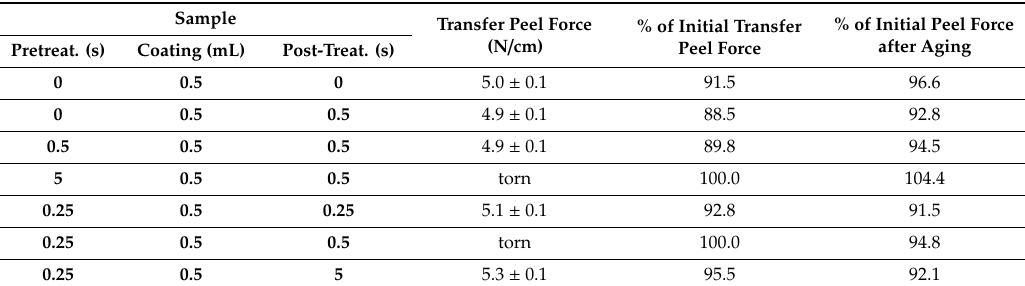
Table 1. The transfer peel force and percentage values of initial peel force right after treatment and after the 3 months of sample aging presented in Figure 2.